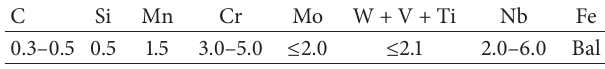
Table 1: Chemical composition of hardfacing materials (wt%). Table 2: Hardness of different samples.